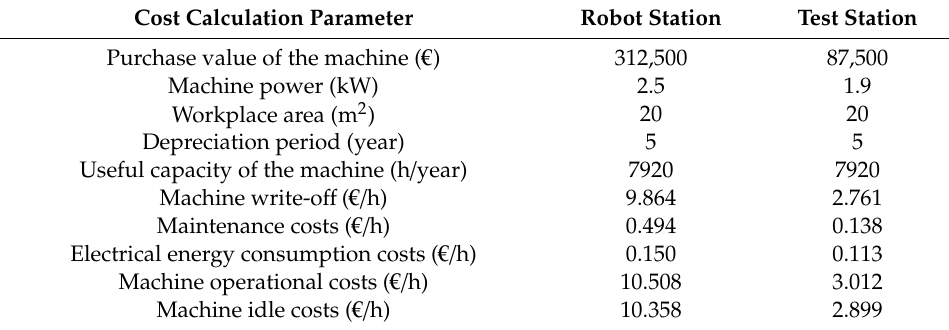
Table 2. Workplace costs calculated